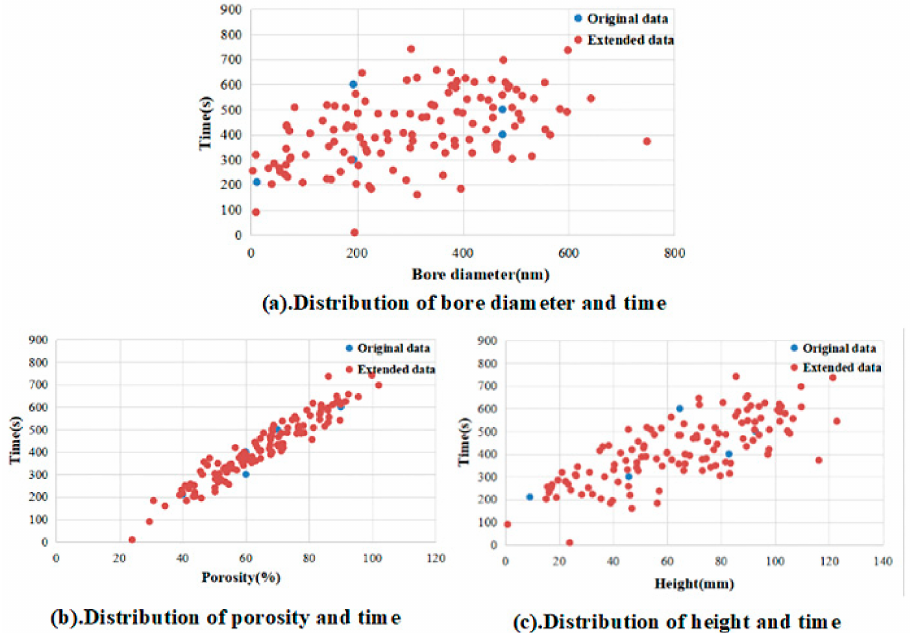
Figure 5. Comparison of the distribution of original data and extended data. (Among which, subfigures ( a – c ) represent the corresponding relationship between bore diameter, porosity, height and time, respectively).